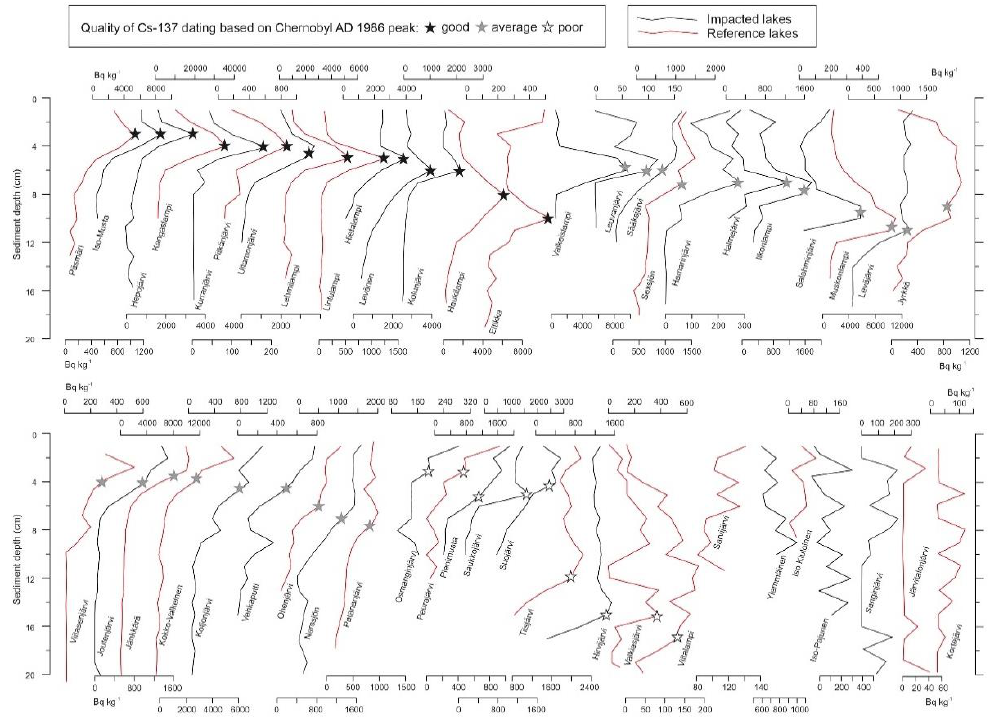
Figure 5. Cesium ( 137 Cs) profiles of the studied lake sequences with black curves representing impact lakes and red curves representing reference lakes. Stars indicate the depth of Chernobyl-derived cesium fallout with di ff erent dating quality classifications. All concentration are expressed as Bq kg − 1 .